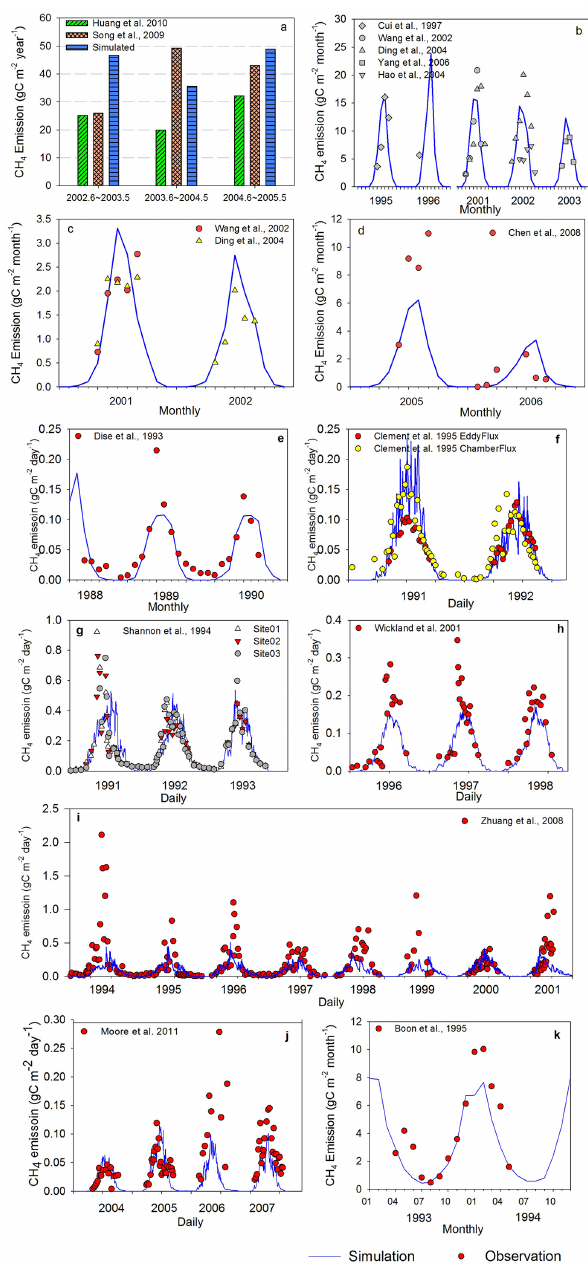
Figure 4. Comparison of modelled and observed CH 4 emissions for the sites located in the temperate